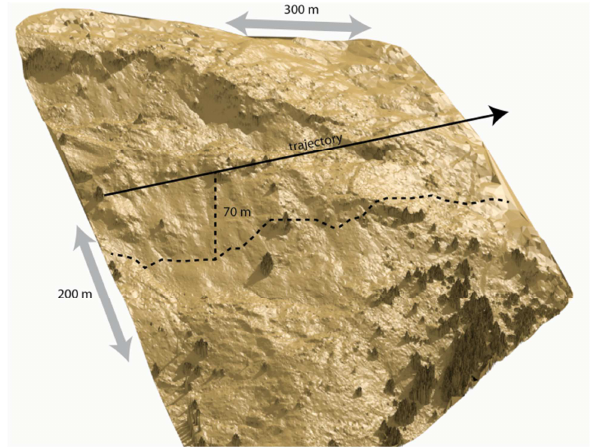
Figure 5. Polygonal DSM of the complex test area, used for simulation